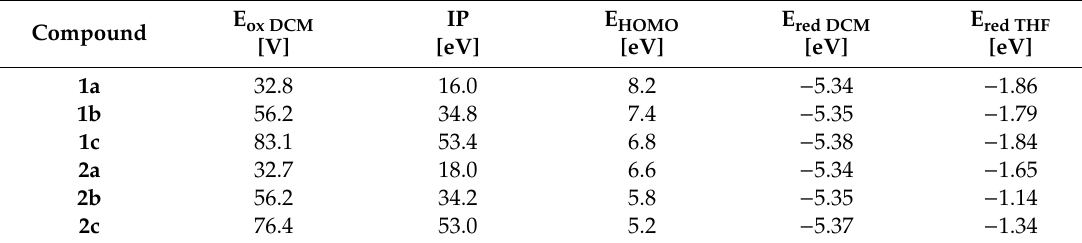
Table 2. The numerical data of the cyclic voltammetry